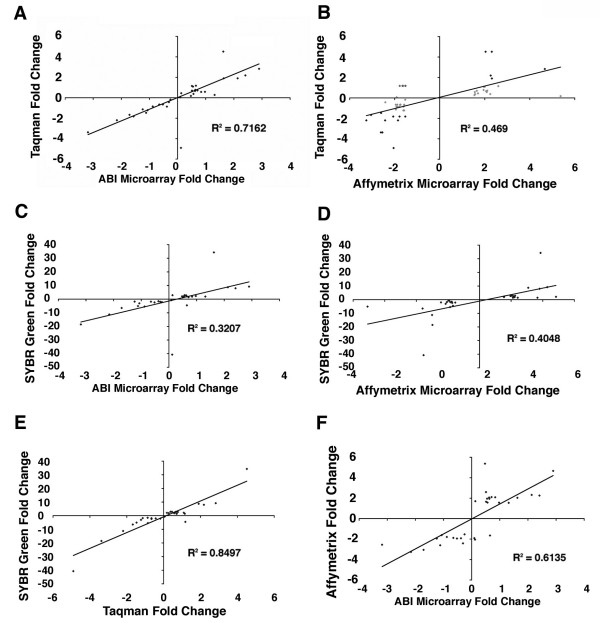
(A) QRTPCR validation of the AB Expression Array System measured Fold Change of gene expression data between HEK-TERST and HEK-TERV cells. Fold change values from the AB platform are plotted on the x-axis and TaqMan assay based QRTPCR fold change is plotted on the y-axis. Data for the same set of genes are shown in all panels (A-F). (B) QRTPCR validation of the Affymetrix measured Fold Change of gene expression data between HEK-TERST and HEK-TERV cells. Fold change values from the Affymetrix platform are plotted on the x-axis and TaqMan assay based QRTPCR fold change is plotted on the y-axis. (C) Comparison of SYBR Green reagent based QRTPCR data to the AB Expression Array System fold change data. (D) Comparison of SYBR Green regent based QRTPCR data to the Affymetrix fold change data. (E) Comparison of the SYBR Green regent based QRTPCR data and the TaqMan assay based QRTPCR data. (F) Scatterplot comparison of the Affymetrix measured and AB Expression Array System measured Fold Change of gene expression data between HEK-TERST and HEK-TERV cells.